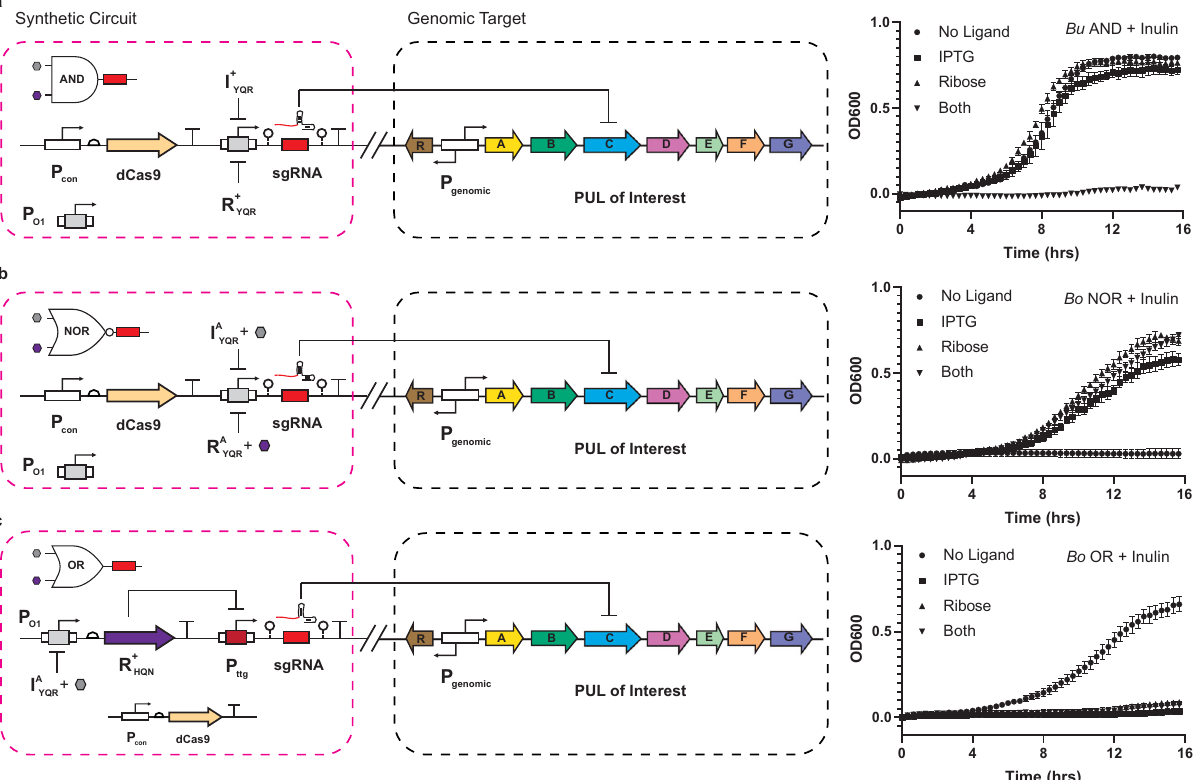
Fig. 5 Advanced regulation of endogenous carbon utilization genes. a Wiring diagram for an AND gate controlling a sgRNA output targeted to an endogenous gene (left). The sgRNA is the same as in Fig. 4e. Growth curves are shown for B. uniformis harboring this circuit when grown in inulin minimal media in the presence of all combinations of both inducers (10 mM IPTG and 1 mM D-ribose) (right). b Similar to a , but for a NOR gate controlling a sgRNA targeted to the B. ovatus SusC-like gene involved in inulin import. c Similar to b , but for an OR gate controlling the sgRNA output. Source data are provided as a Source Data fi le. For OD600 growth curves, data represent the average of n = 3 biological replicates. Error bars correspond to the SEM of these